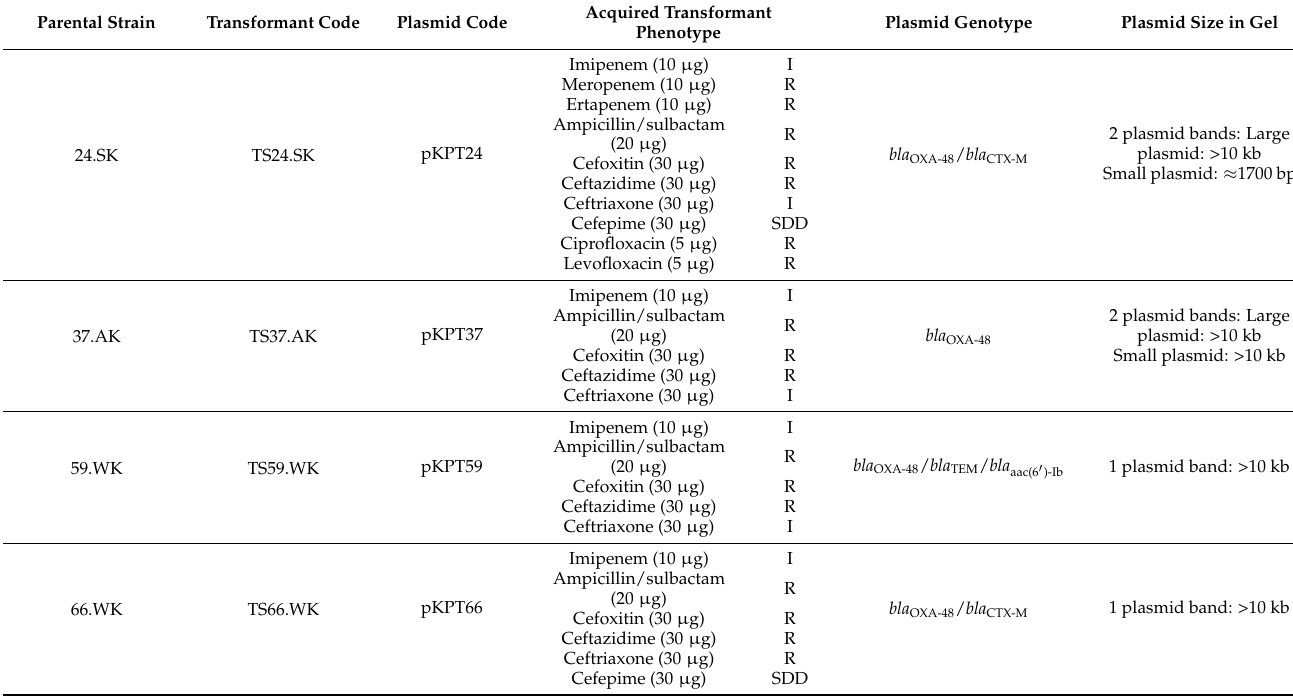
Table 6. Phenotypic and genotypic characteristics of the transformed